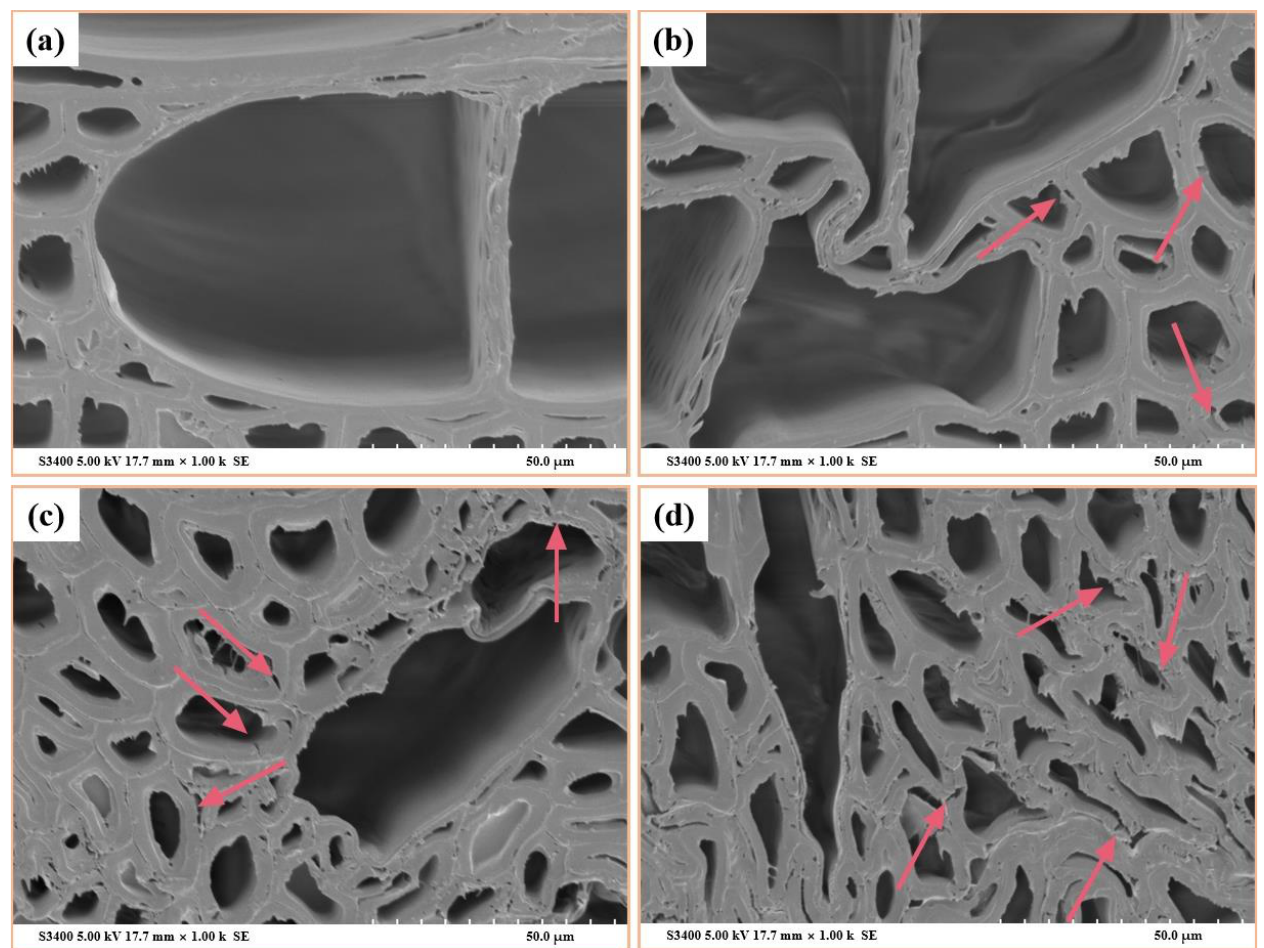
Figure 7. SEM images of the control specimen ( a ), SCW ( b ), SCW + AHT ( c ), and SCW + PHT. ( d ) Microcracks (arrows). SCW, surface-compressed wood without post-treatment; SCW + AHT, surface-compressed wood with atmospheric steam heat treatment; SCW + PHT, surface-compressed wood with pressurized steam heat